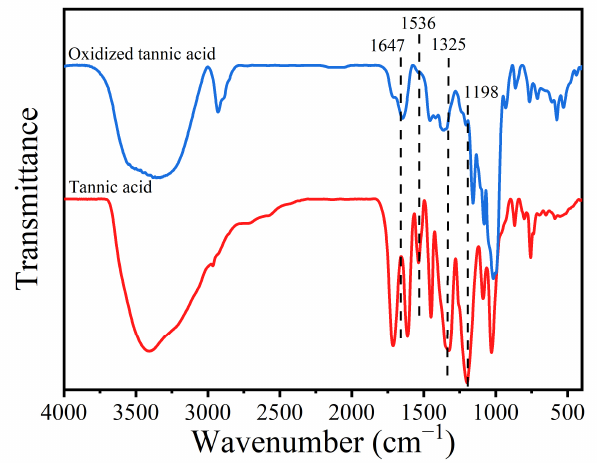
Figure 1. Fourier ‐ transform infrared ( FT ‐ IR) spectra for TA and OTA.